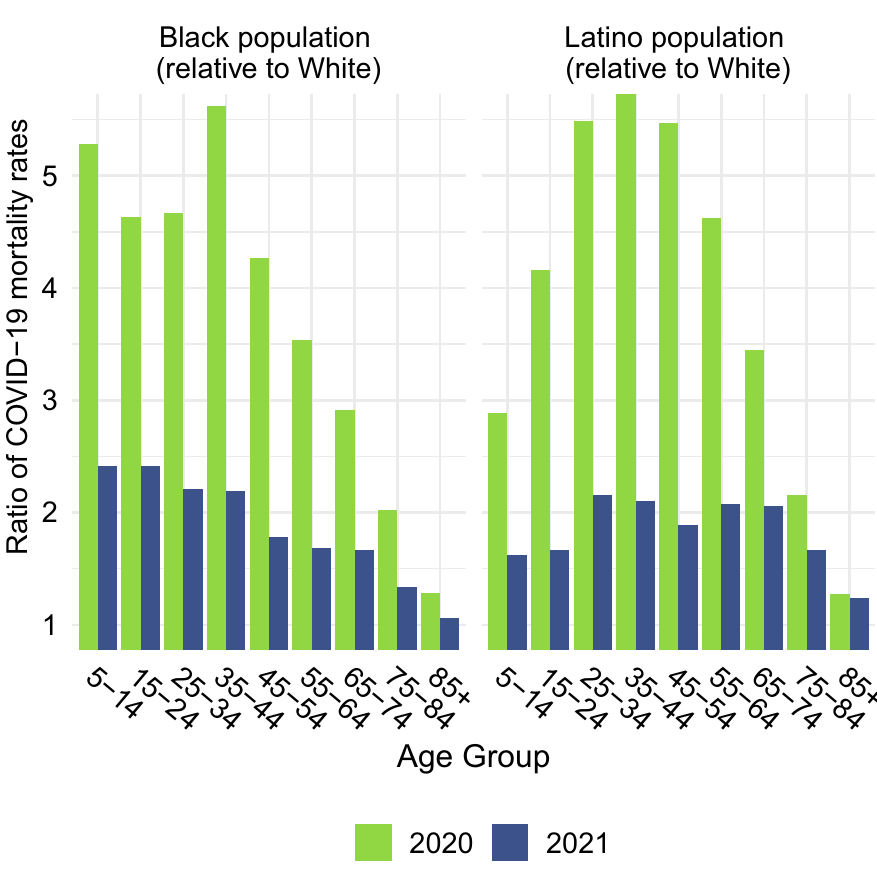
Fig 3. Ratio of age-specific COVID-19 mortality rates for the Black and Latino populations relative to the White population, 2020 and 2021. Data are from CDC WONDER (July 6, 2022, update). Ratios below age 5 are not shown because some counts are